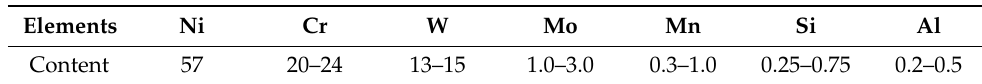
Table 3. Chemical compositions of Haynes 230 (wt%).